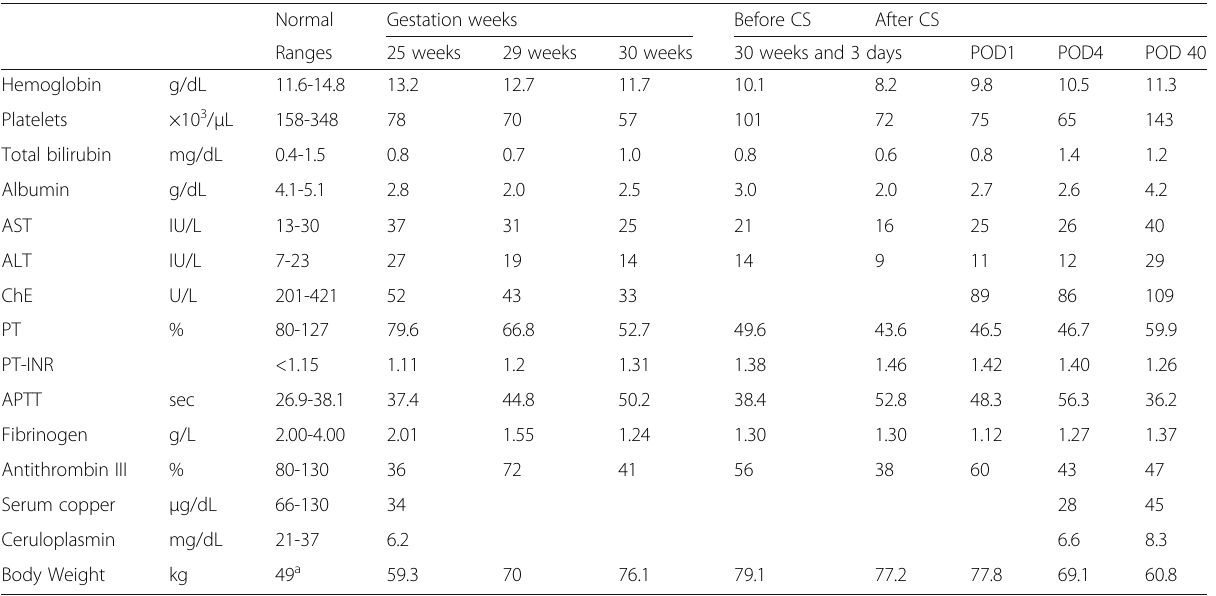
Table 1 Peripartum data of liver function, coagulation, copper metabolism and body weight Normal Gestation weeks Before CS Ranges